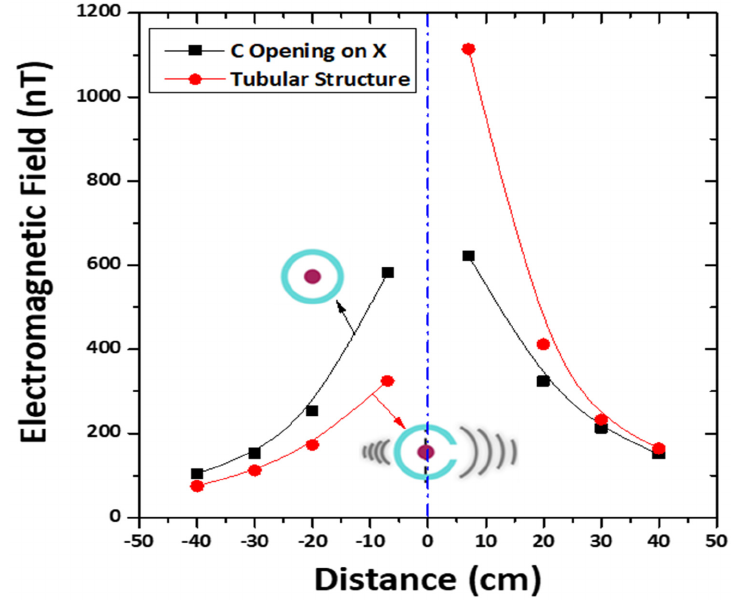
Figure 5. The measured electromagnetic fields in the C-shape composite device. Table 3. Results of electromagnetic fields (peak value) in the C-shaped cylindrical device. Distance (D) in Tubular Permalloy (T) in cm nT